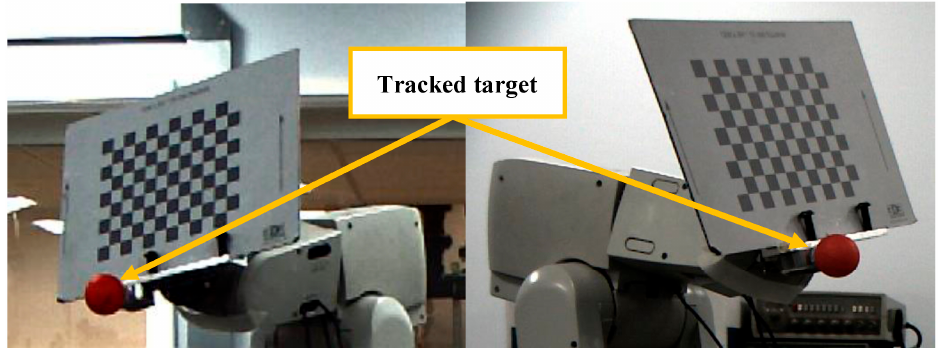
Figure 1. Front view ( left ), side view ( right ).